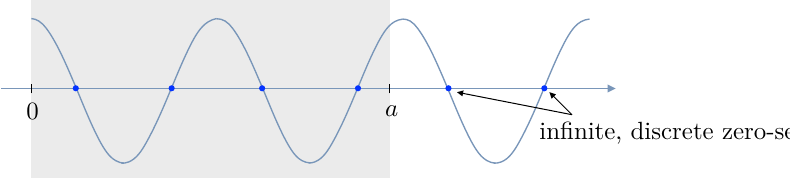
Figure 2 . Graph of cosine function on R is non-definable set, but becomes definable when restricted to domain 0 ≤ φ ≤ a